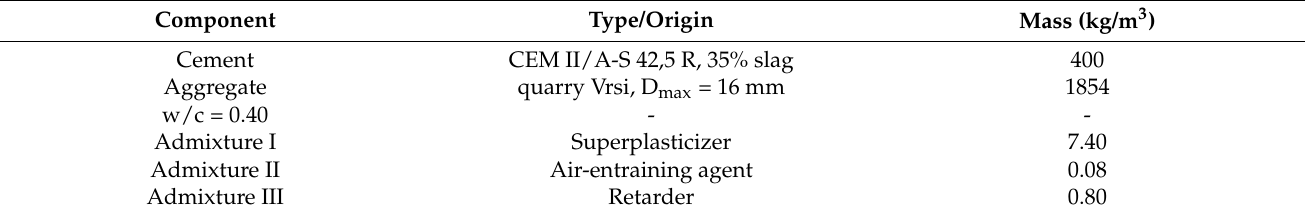
Table 2. Concrete mix for the Maslenica